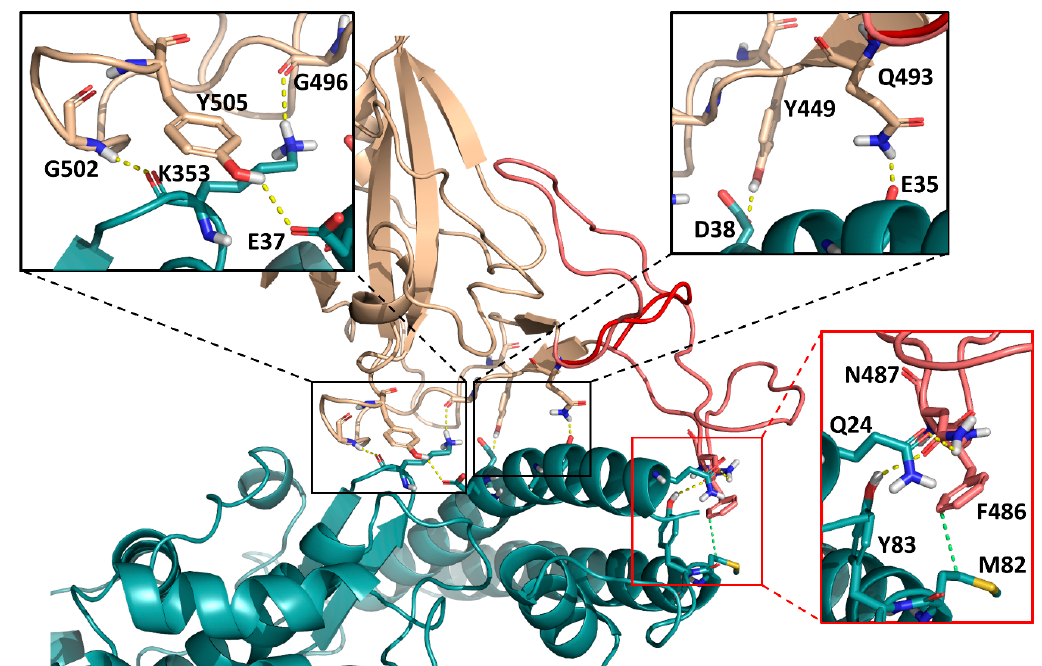
Figure 2. Interface of the angiotensin-converting enzyme 2 (ACE2) receptor (light blue) with the SARS-CoV-2 spike protein receptor-binding domain (tan), visualized based on PDB structure 6M17. Amino acids that were identified as part of the three interaction segments are included as sticks and highlighted in the three insets. In the modeled RBD Δ 84 mutant, an extended loop (amino acids 460–488, light red/salmon) is replaced by a compact turn (dark red, average structure of the MD simulation), removing the C-terminal interaction segment (red inset) and resulting in a significantly smaller contact surface with the ACE2 receptor (779 ± 31 Å2 for RBD Δ 84 vs. 921 ± 3 Å2 for the wild-type protein). This, in turn, should result in weakened ACE2 binding.